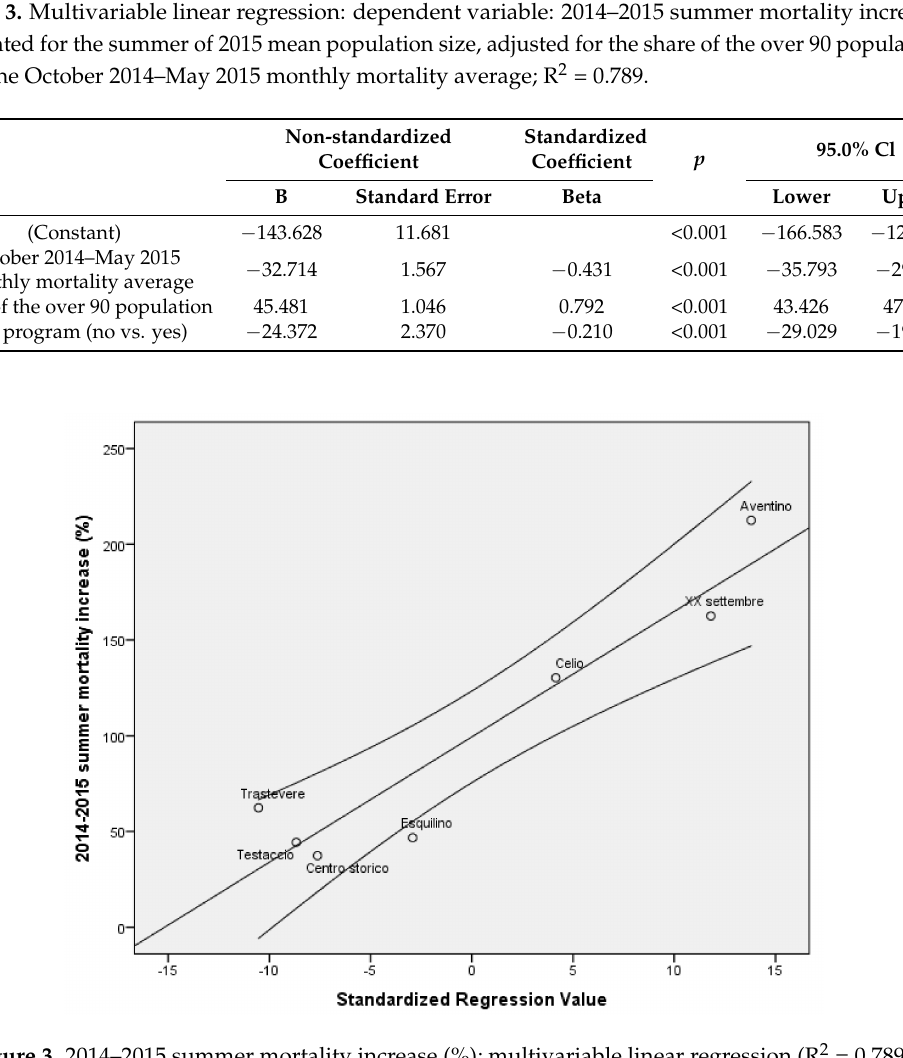
Figure 3. 2014–2015 summer mortality increase (%); multivariable linear regression (R 2 =